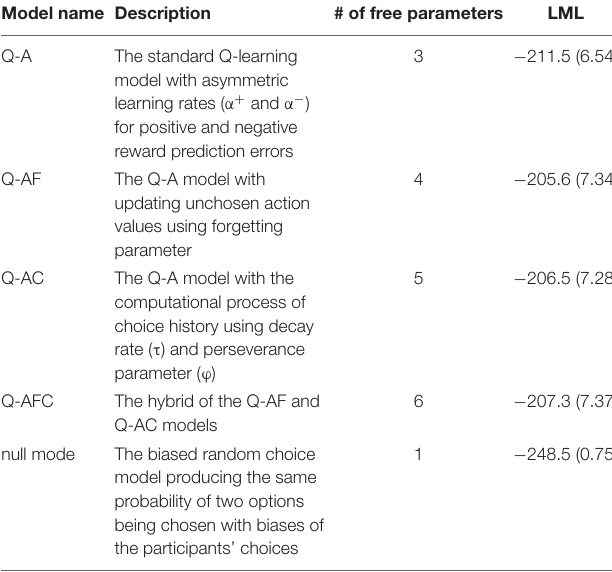
TABLE 1 | Information concerning the five models compared on the basis of their fit to the choice data from 36